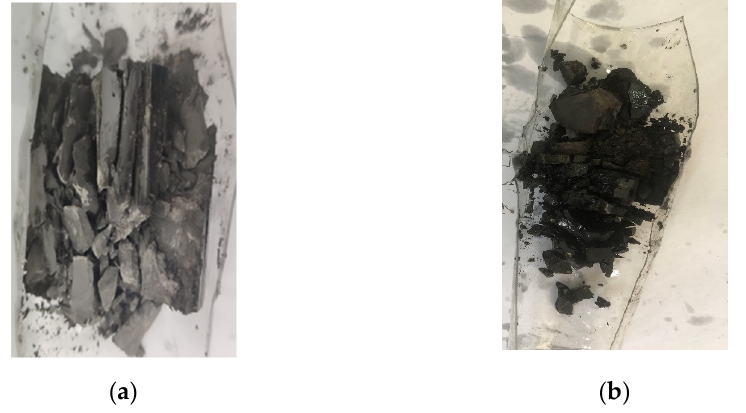
Figure 3. Photos of shale destroyed in triaxial compression experiment: ( a ) photo of shale being destroyed when loaded parallel to the bedding direction; ( b ) photo of shale being destroyed when loaded perpendicular to the bedding direction.